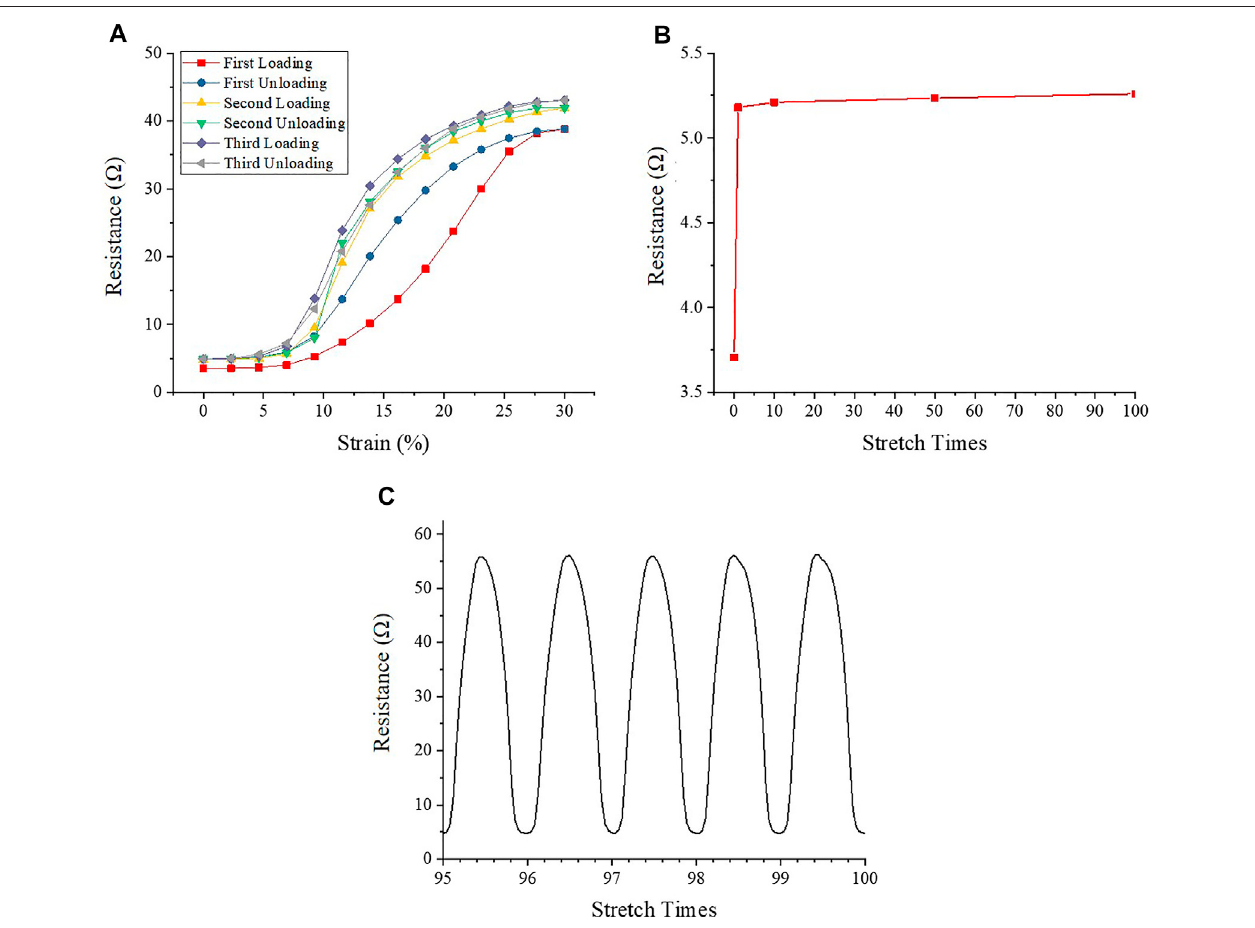
FIGURE 2 | The electrical resistance of AgNWs/PDMS electrode under mechanical loading cycles. (A) Electrical resistance during repeated stretch-relaxation cycles(the fi rsttothirdcycles). (B) ElectricalresistanceofAgNWs/PDMSelectrodewithnostrainafterstretch. (C) Electricalresistanceduringrepeatedstretch-relaxation cycles (the last fi ve